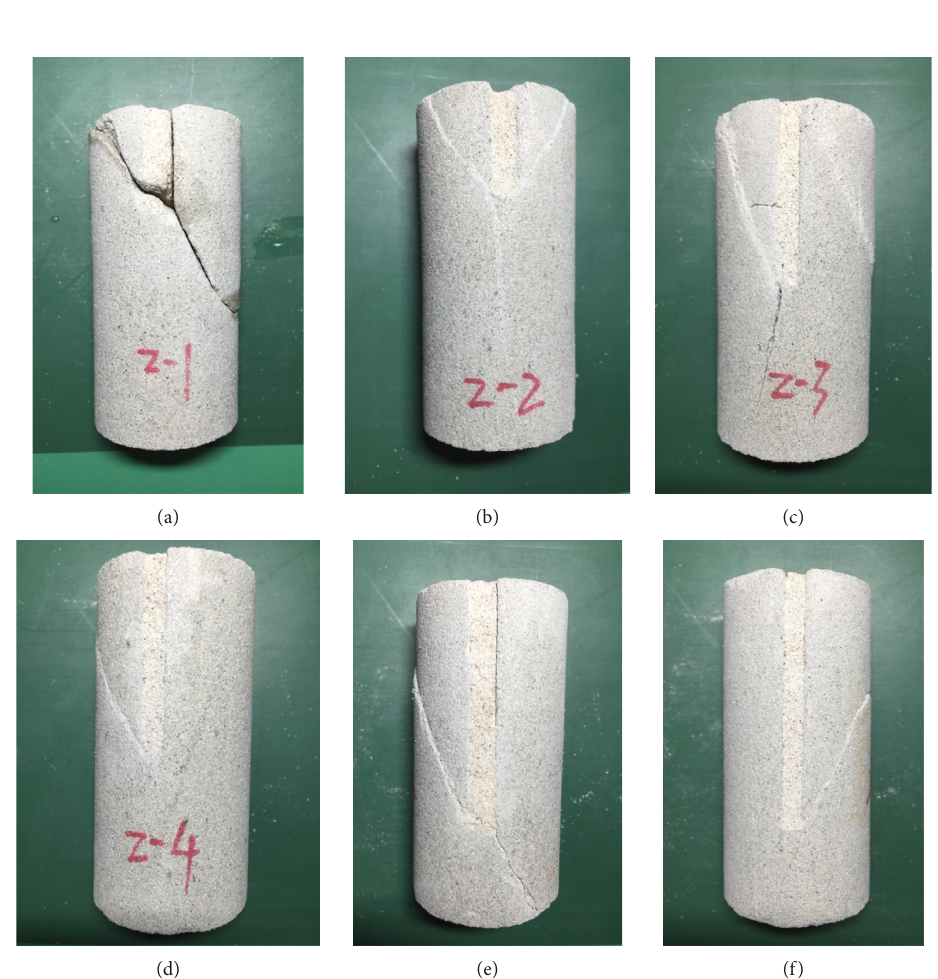
Figure 8: Destruction pictures of cracked sandstone filled with cement mortar. (a) 2-1. (b) 2-2. (c) 2-3. (d) 2-4. (e) 2-5. (f)